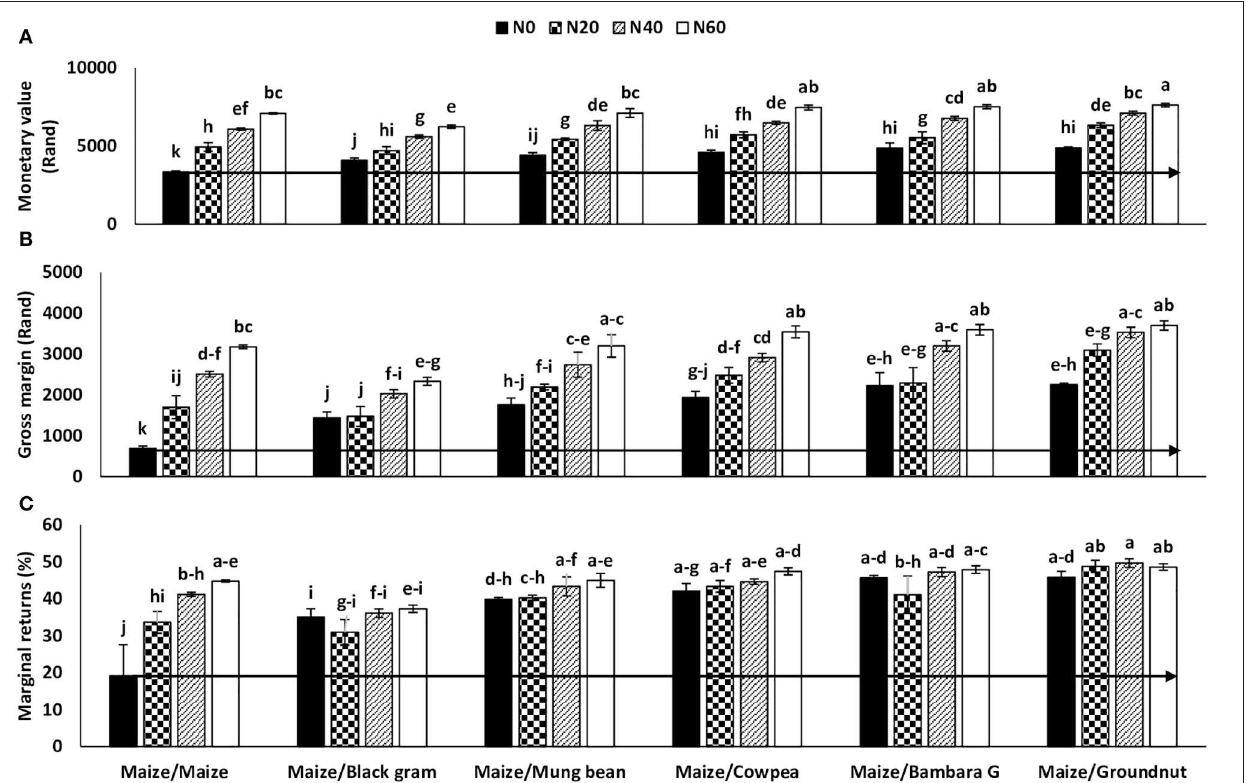
FIGURE 4 | Interaction effect of preceding crop and N fertilizer rate on the (A) monetary value, (B) gross margin, and (C) marginal returns of maize planted in rotation at Nelspruit, Mpumalanga Province during the 2012/2013 cropping season. The horizontal line delineates increases in yield caused by N20, N40, and N60 relative to N0.